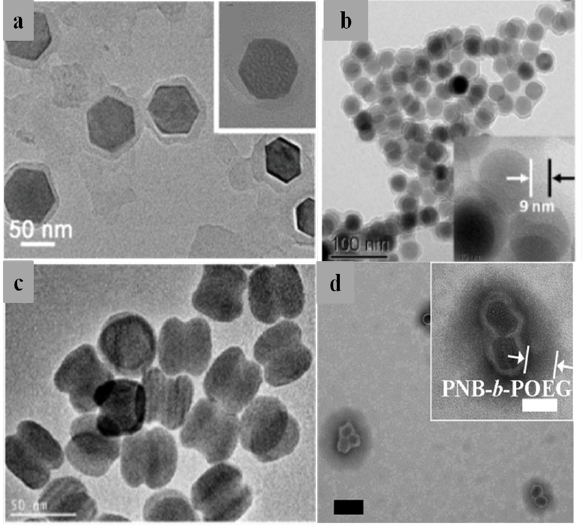
Figure 5: a) TEM images of NaYF 4 :Yb/Er@PPy